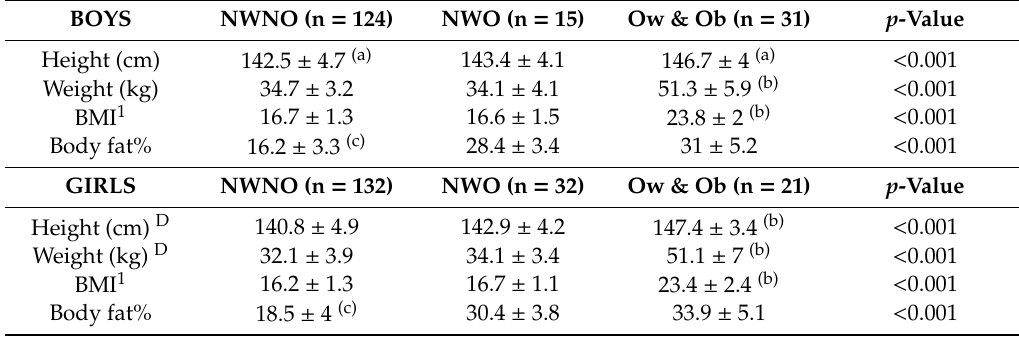
Table 3. Anthropometry profile of children in three defined categories considering sex. BOYS